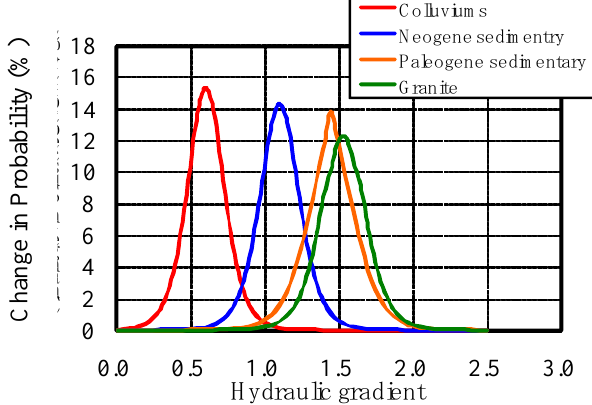
Fig. 10. Variation in probability Vs change in hydraulic gradient for 350m relief